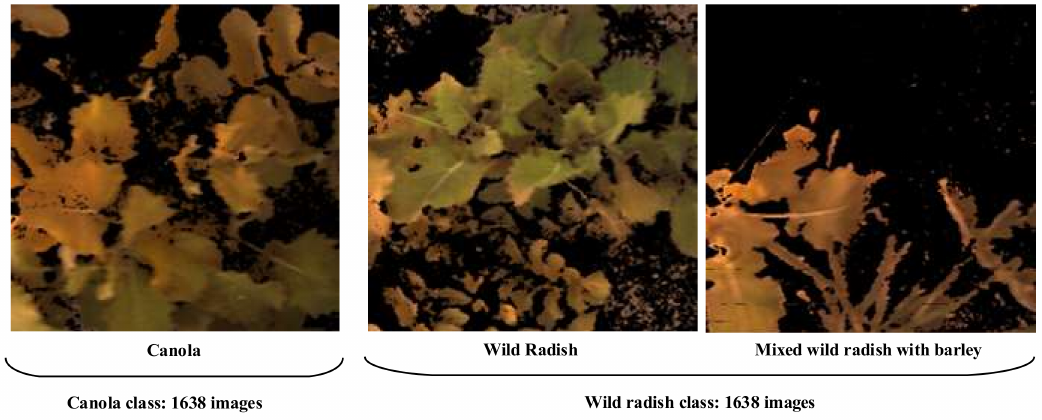
Figure 6. Segmented canola and wild radish classes under complex field